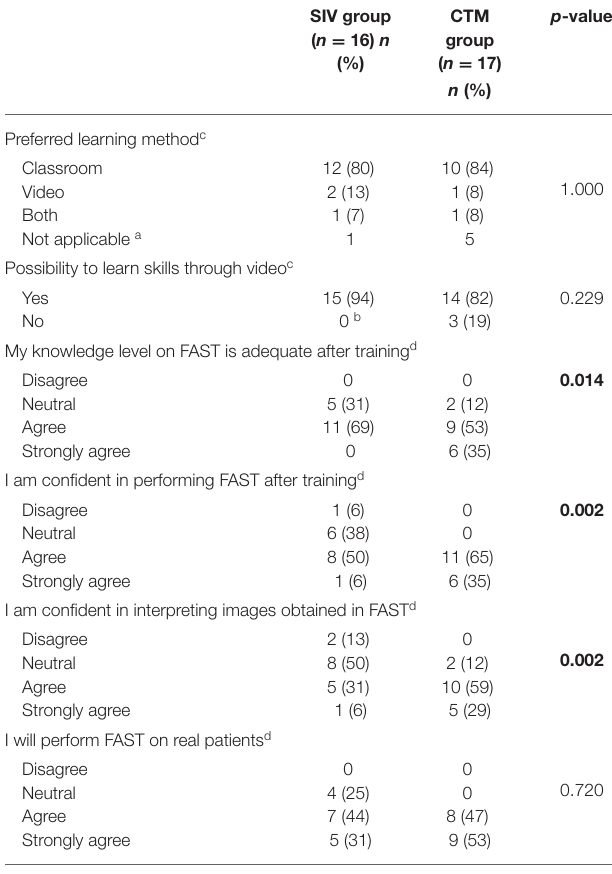
TABLE 3 | Summary of response from participants regarding their confidence level and preferred learning